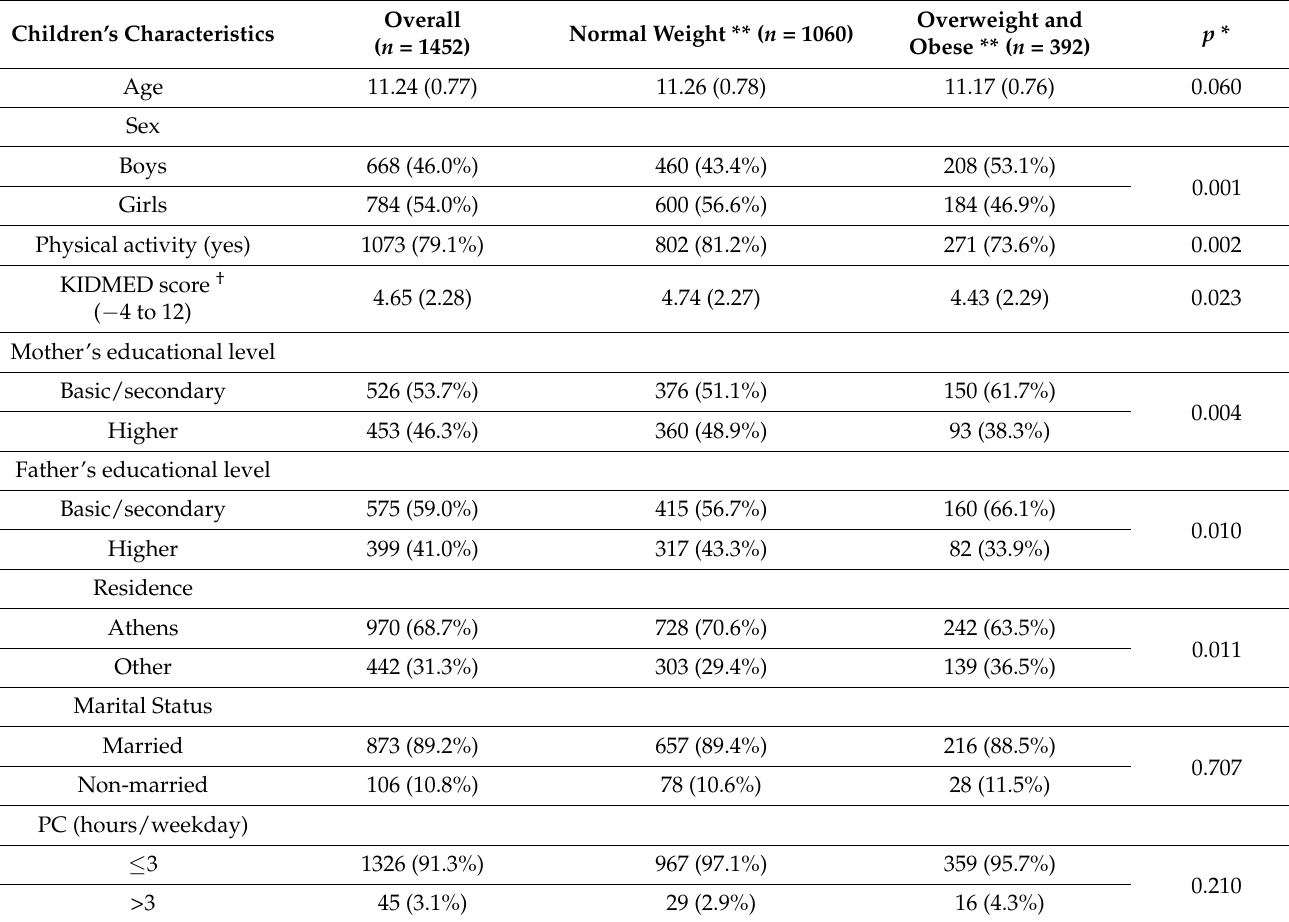
Table 1. Children’s sociodemographic characteristics and lifestyle habits, by body weight